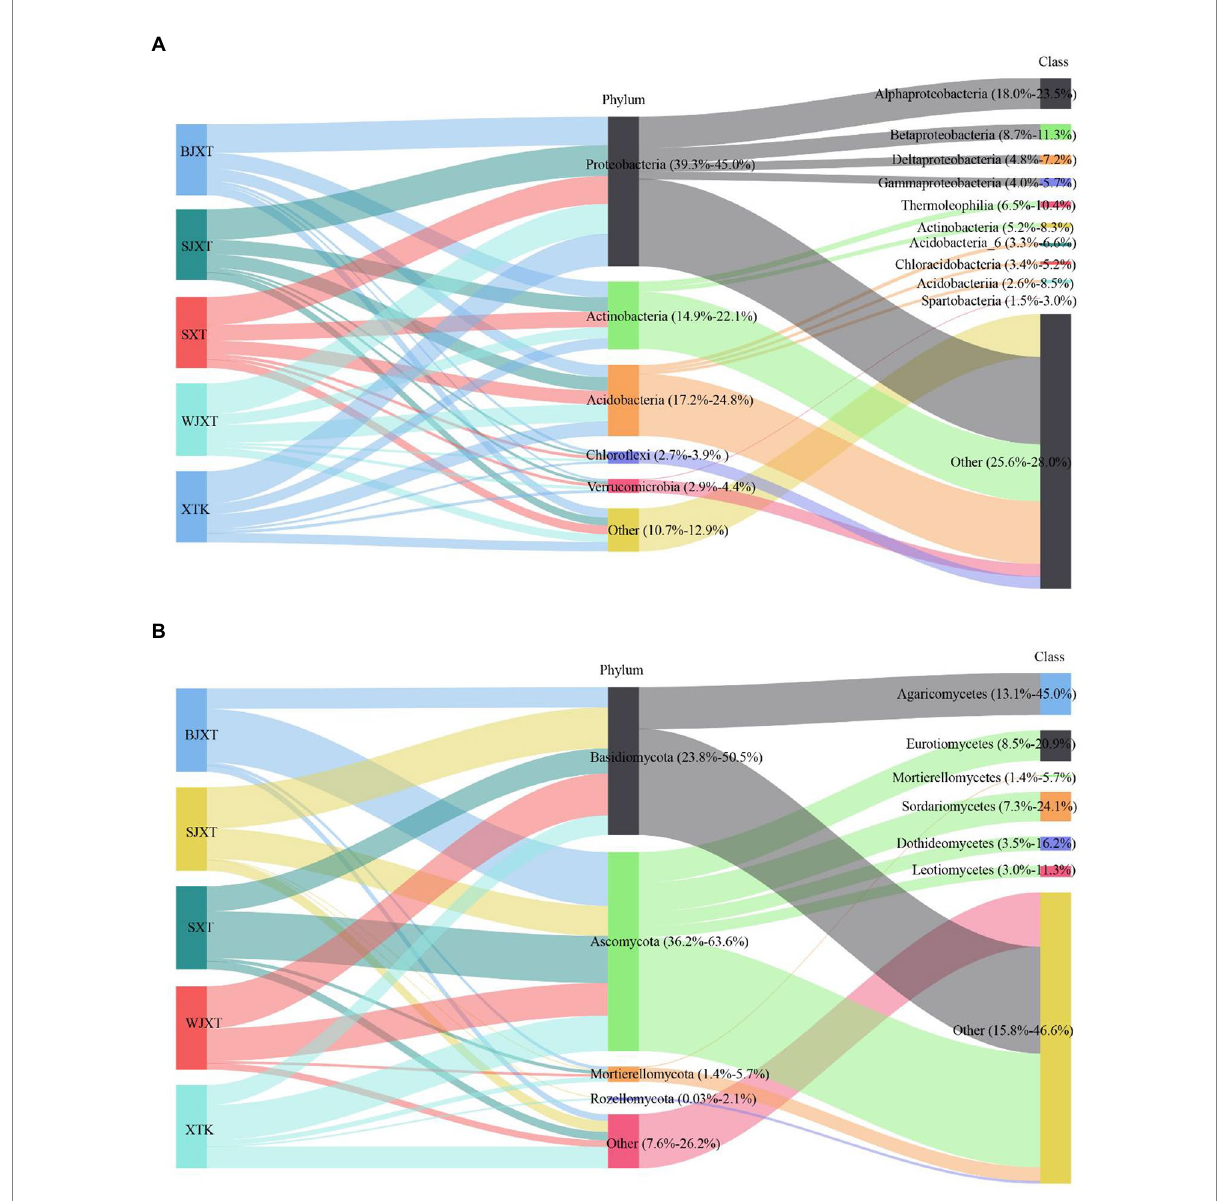
FIGURE 1 The Sankey diagram of the composition of bacterial (A) and fungal (B) communities at phylum and class level in five karst tiankengs. BJXT: Bajiaxiantang, SJXT: Shaojiaxiantang, SXT: Shenxiantang, WJXT: Wangjiaxiantang, XTK: